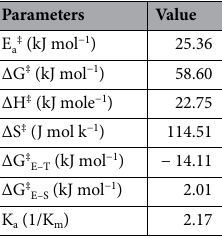
Table 6. Thermodynamic parameters for the activation energy of CelC307. The parameters were measured after 6 h incubation at various temperatures, and the values were obtained at 40 °C.